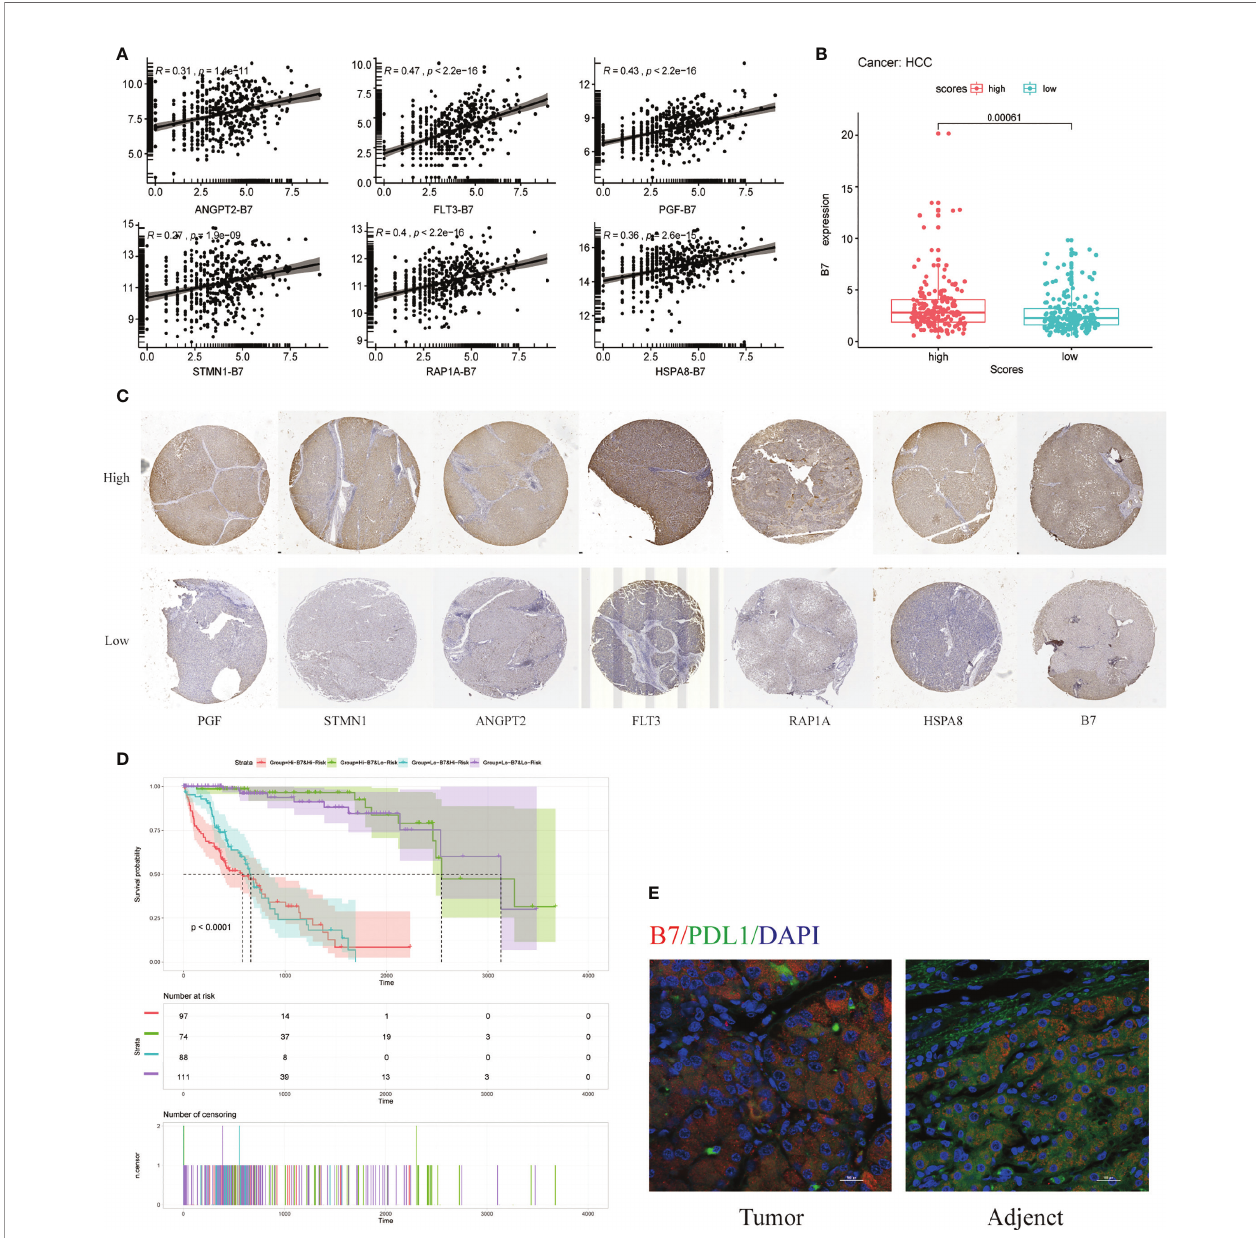
FIGURE 9 | Effect of the risk signature and immune checkpoint gene expression on patient survival. (A) Association between the risk signature and immune checkpoint gene expression. (B) Association between the hub gene and immune checkpoint gene expression. (C) Immunohistochemical staining was used to compare the expression of PGF, STMN1, ANGPT2, FLT3, RAP1A, HSPA8 with B7 in HCC tissues. (D) Kaplan – Meier survival curves of OS among patient groups strati fi ed by the risk signature and immune checkpoint gene expression. (E) Association between B7 (CD80) and PDL1 in HCC tissues compared with adjacent tissues. Supplemental Figure Immunohistochemistry was used to detect the negative control, high and low expression of PGF, STMN1, ANGPT2, FLT3, RAP1A, HSPA8, and B7 in HCC tissues at high and low magni fi